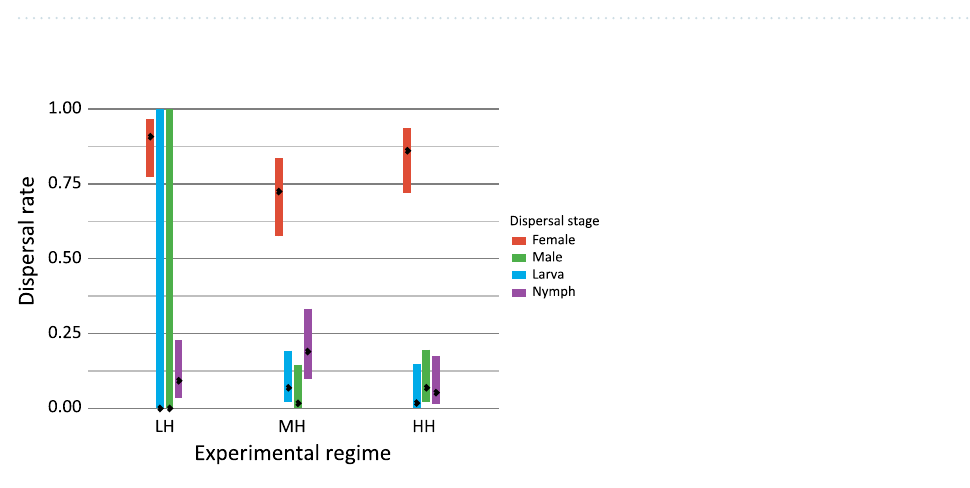
Figure 3. Dispersal rate of different developmental stages in each experimental regime. There were no males and larvae dispersing in the LH colony, so the dispersal rate is predicted between 0 and 1. Dots represent means and bars denote 95%